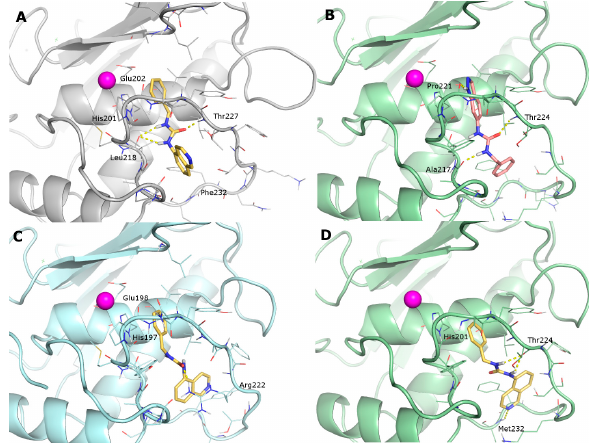
Figure 5. Docking poses of: ( A ) 1h in the MMP-2; ( B ) 1m in the MMP-13; ( C ) 1h in the MMP-8; and ( D ) 1h in the MMP-13. MMPs are represented as grey (MMP-2), pale cyan (MMP-8) and pale green (MMP-13) cartoons. The zinc ion is a purple sphere; most relevant residues are represented as lines and ligands as sticks. H-bonds are depicted as yellow dashed lines.